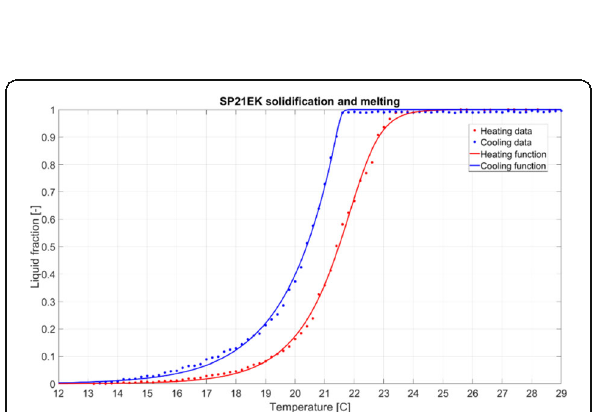
Fig. 5 (Abstract P7). Hysteresis characterization of the utilized PCM [5,